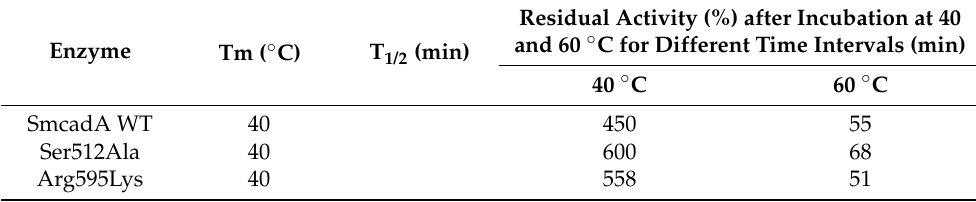
Table 1. Thermostability of wild-type SmcadA and mutants.